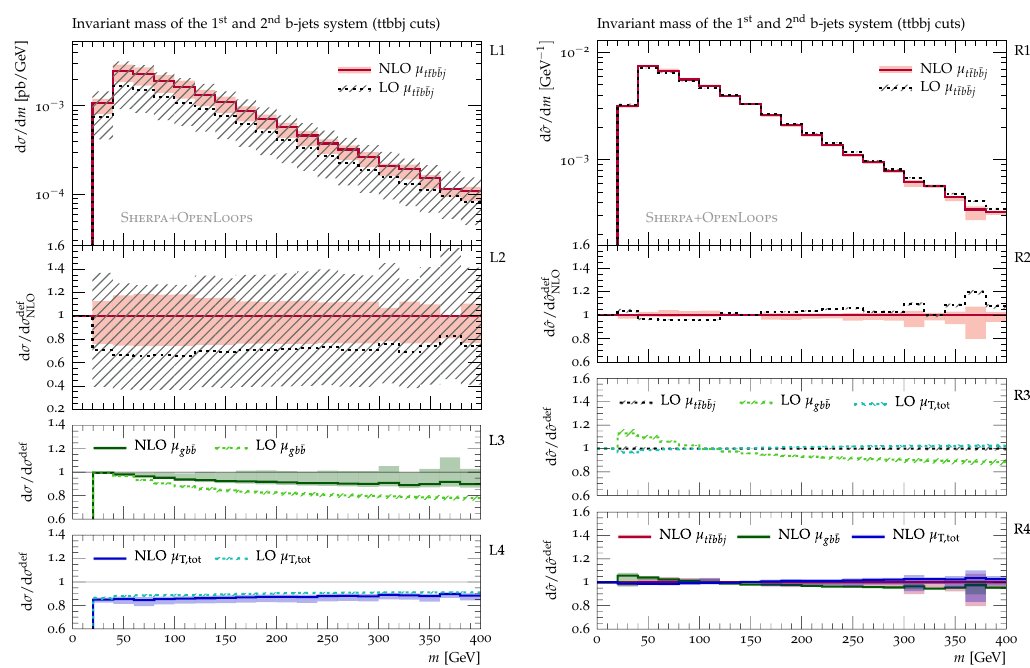
Figure 16. Invariant mass of the b -jet pair. Same setup and plots as in (cid:12)gure